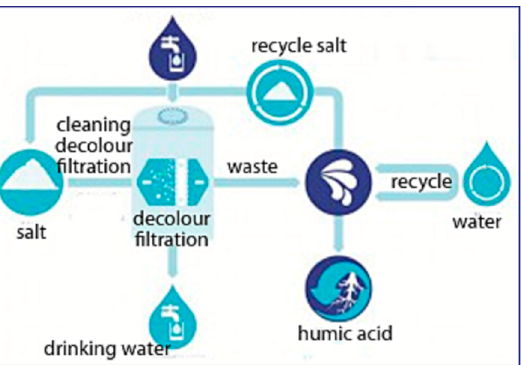
Figure 4. Process flow diagram of the HumVi technology to recover humic acid from wastewater. Adapted from ref. [75].